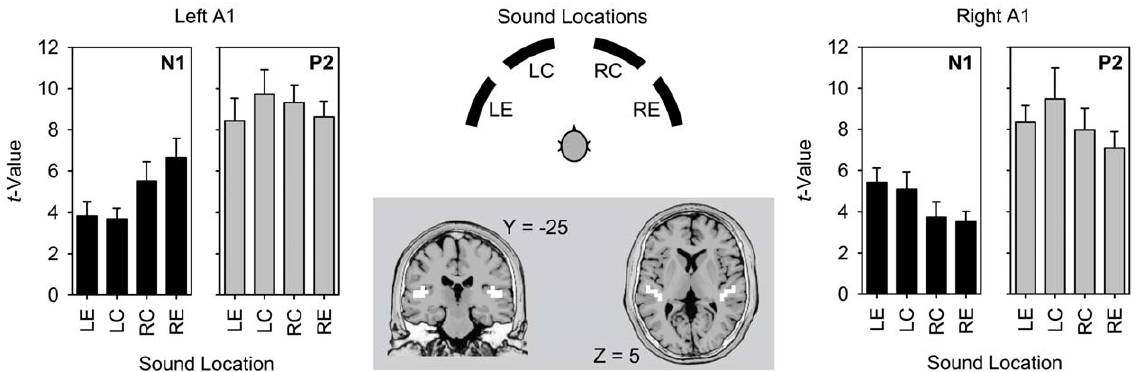
Figure 3. ROI-analysis of primary auditory cortex (BA 41) at the time of the N1 and P2. Data were collapsed for four adjacent loudspeaker positions, resulting in four data sets, each covering a range of 40 degrees (LE, left eccentric; LC, left central; RC, right central; RE, right eccentric; black arcs in the schematic view of the set-up). In the coronal and horizontal slices (MNI-template as in Fig. 2), voxels of the ROI are marked in white. The plots show t -values as a function of sound location (error bars, standard errors across subjects), resulting from contrasts of activations with a 40-ms prestimulus period of silence for the whole ROI.